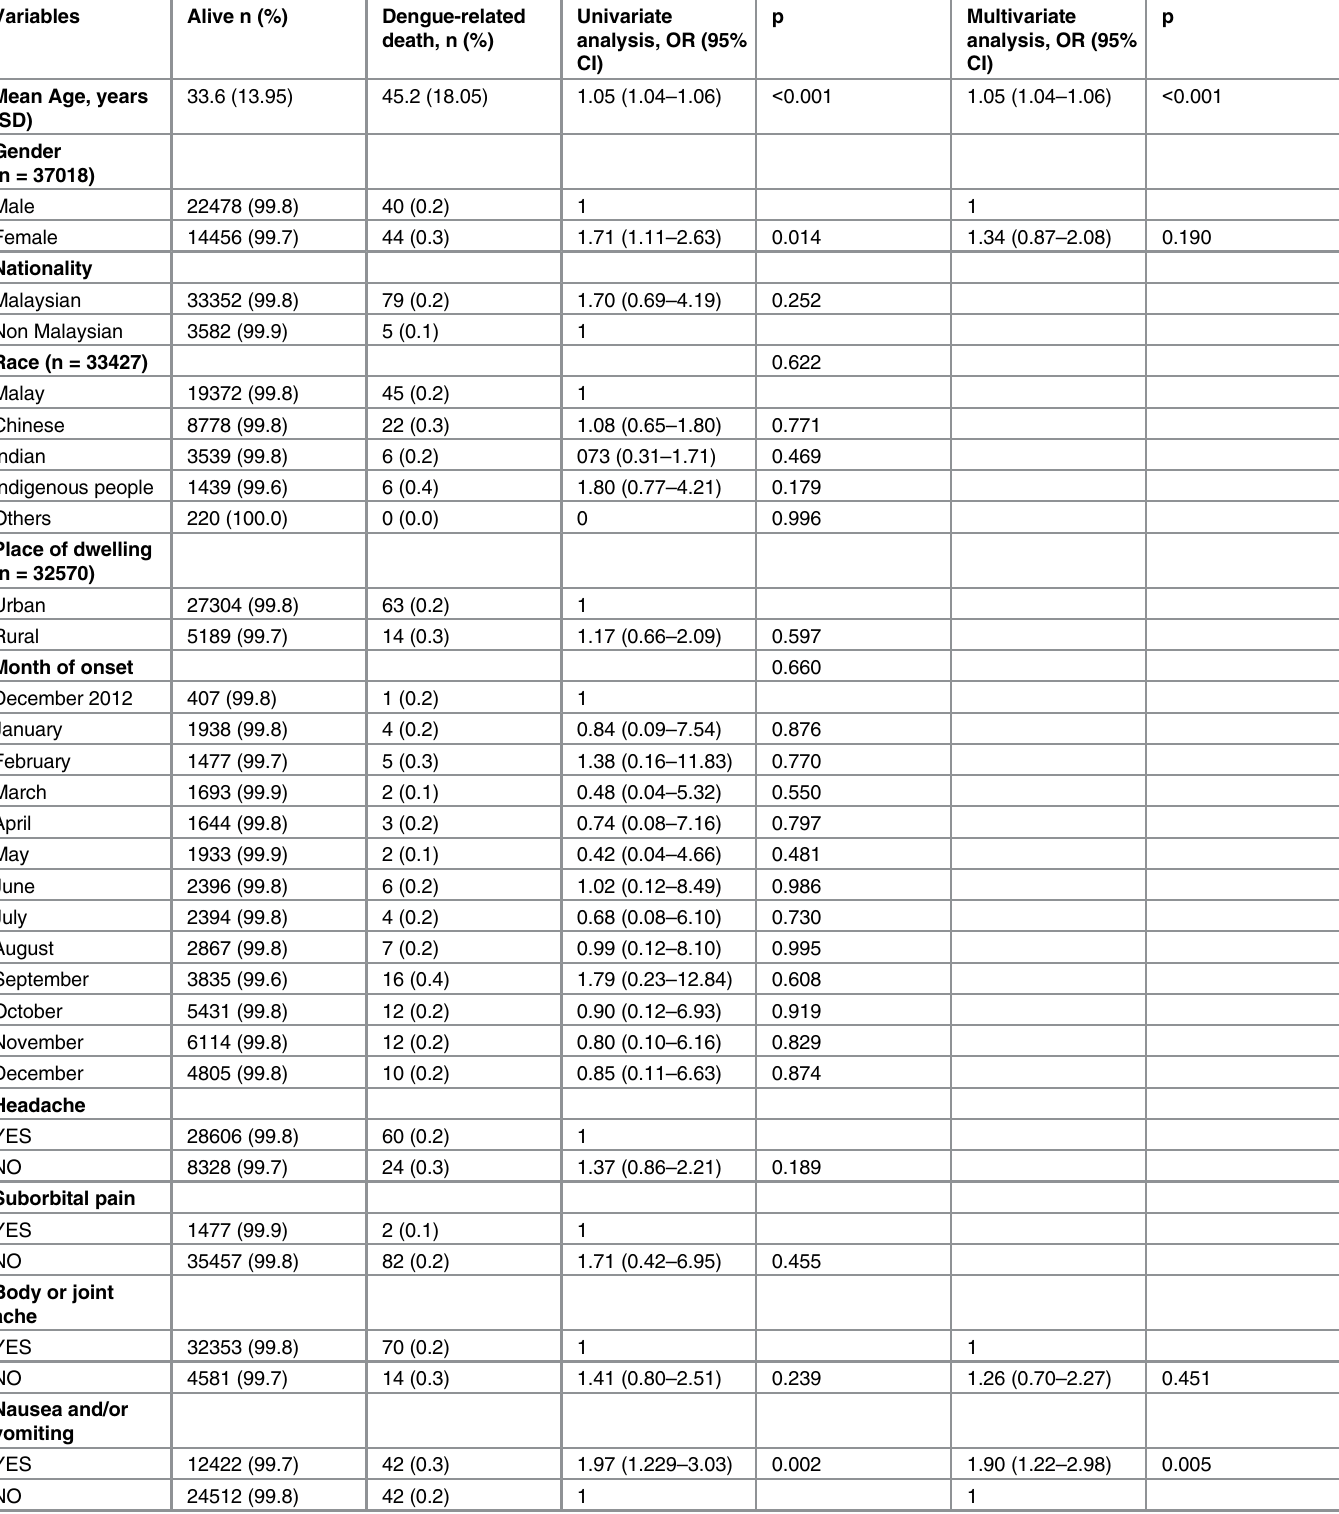
Table 5. Univariate and multivariate analysis (n = 37021) of probable dengue-related mortality in Adults ( (cid:1) 15 years old).